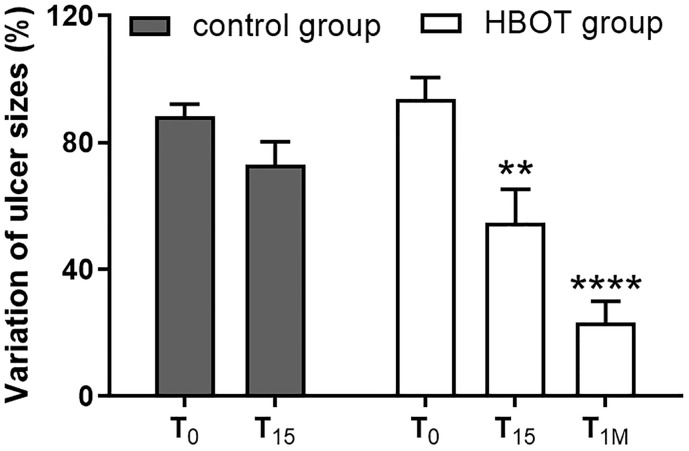
Variation of ulcer sizes at different time points during and after HBO therapy in patients with chronic non-healing wounds.Ulcer sizes were determined for control group patients during the first evaluation (T0) and after fifteen days of conventional wound therapy (T15); for patients in HBOT group before (T0), after 15 HBO sessions (T15) and one month after the last HBO treatment (T1M). Data, expressed as variation of the percentage in ulcer sizes and related to the basal value (T0), represent the mean ± standard deviation of individual samples (control group n = 15; HBOT group n = 15). **p<0.01, **** p < 0.0001 versus T0, both control and HBOT group.